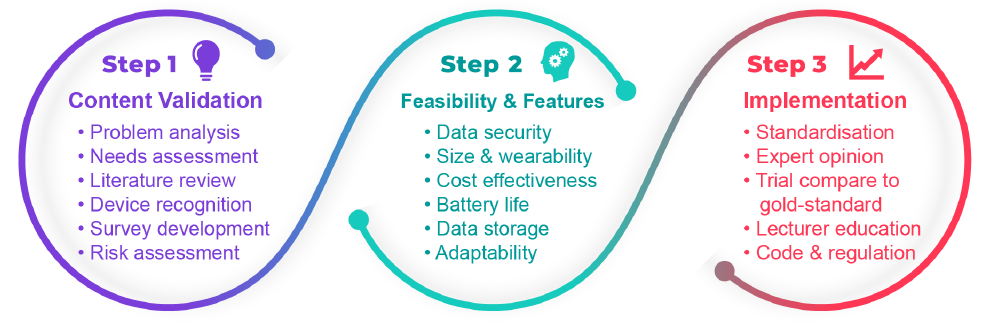
Figure 6. Acceptability route to implementing wearable devices in a higher educational